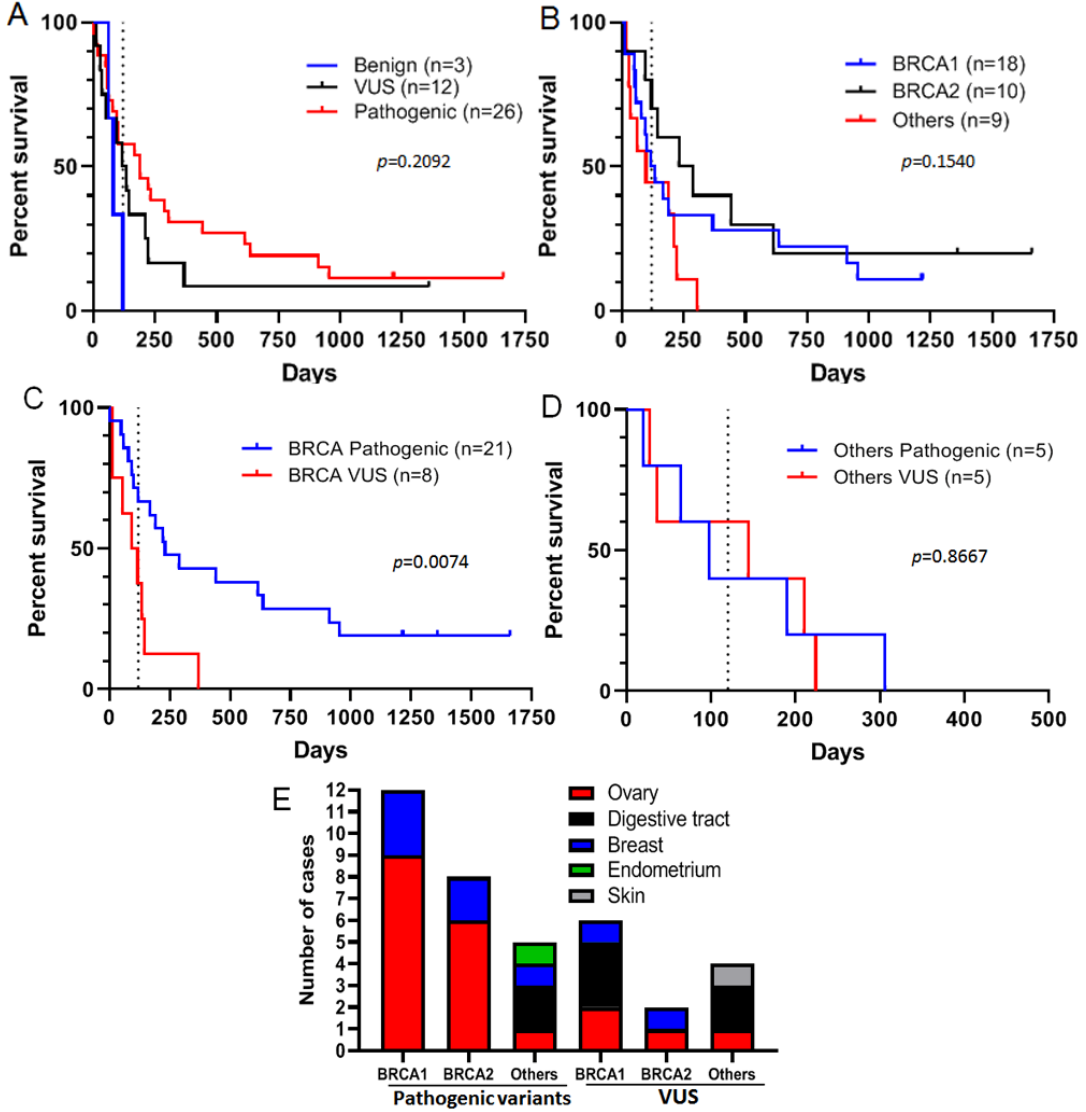
Figure 2. Progression-free survival (PFS) of patients under olaparib treatment according to the pathogenicity of variants detected in tumors. ( A ): PFS of patients with benign (blue), VUS (black), and pathogenic (red) variants in tumors in response to olaparib. ( B ): PFS observed for patients with tumors containing BRCA1 (blue), BRCA2 (black), and other gene (red) variants in response to olaparib. ( C ): PFS observed for patients with tumors containing BRCA pathogenic variants (blue) or BRCA VUS (red). ( D ): PFS observed for patients with tumors containing pathogenic variants (blue) or VUS (red) in other genes. ( E ): The number of pathogenic variants or VUS in BRCA1 , BRCA2 or other genes by site of origin. For all panels: the dashed line corresponds to 120 days.